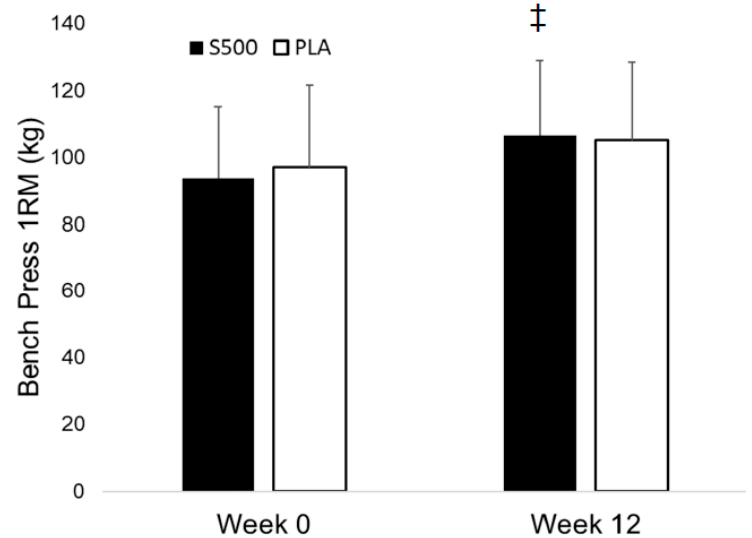
Figure 3. Bench press 1 RM in kilograms for S500 and PLA at week 0 and week 12. Solid bars depict S500 data, while white bars depict PLA data. Data is represented as means ± SD. No difference was found between groups at week 0 and is represented as ‡. A significant group × time interaction ( p = 0.048) with post hoc tests indicating S500 increased bench press 1 RM to a greater extent than PLA.